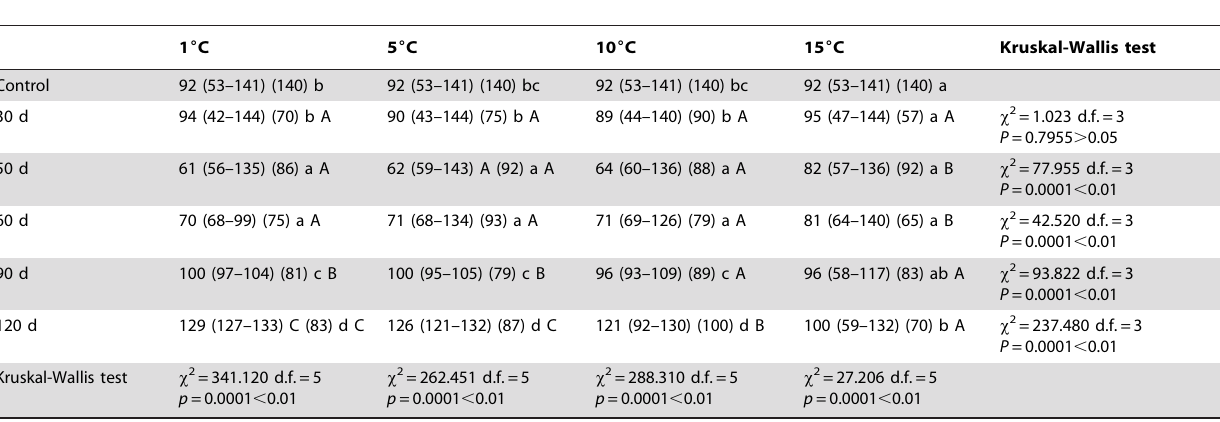
Table 1. Effects of low temperature chilling on diapause termination and post-diapause development in aestivating pupae of P. melete